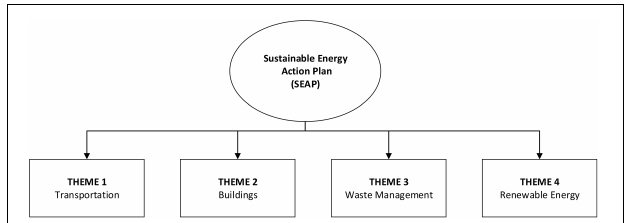
FIGURE 2 | Themes of the Sustainable Energy Action Plan